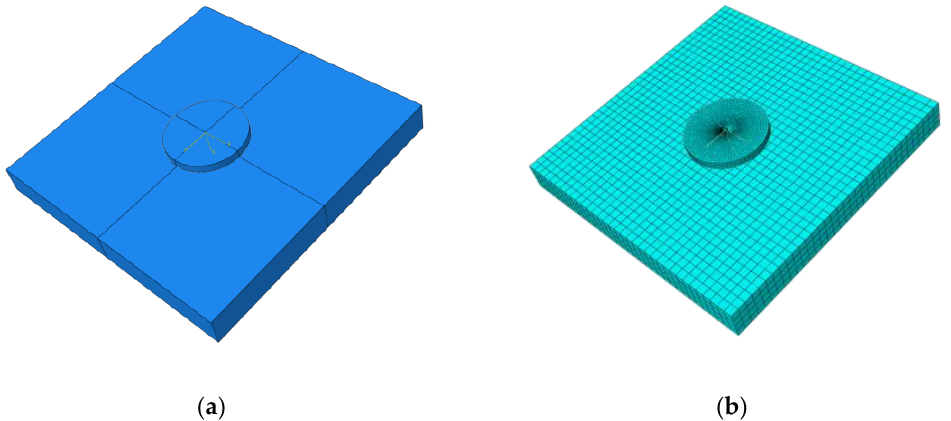
Figure 7. Finite element model: ( a ) full-scale model including sliding plate and ceramic friction material; ( b ) meshing.